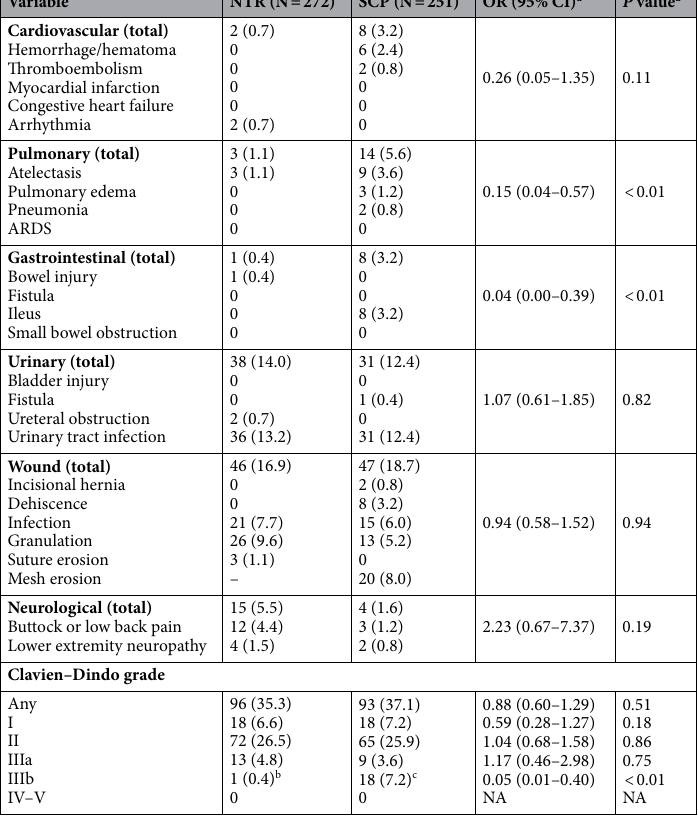
Table 4. Complications and Clavien–Dindo grades. Data are presented as number (%). ARDS, acute respiratory distress syndrome; CI, confidence interval; NA, not applicable; NTR, native tissue repair; OR: odds ratio; SCP: sacrocolpopexy. a Adjusted for age and preoperative POPQ stage. b Includes sigmoid colon perforation detected at postoperative day 8. c Includes vesicovaginal fistula (n = 1), incisional hernia (n = 2), and vaginal mesh erosion (n =